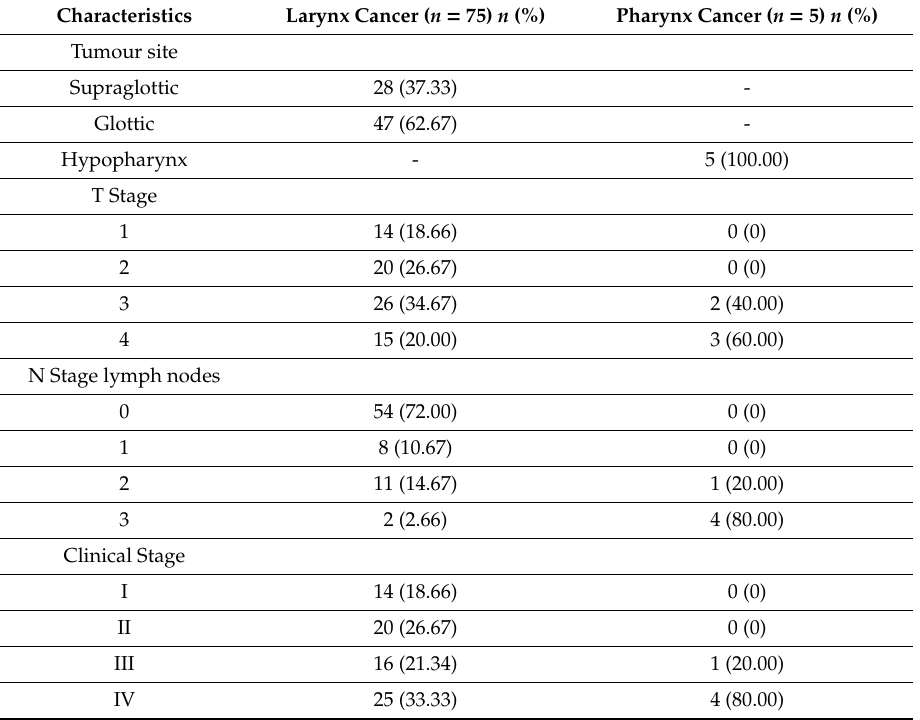
Table 2. Baseline characteristics of larynx / pharynx cancer